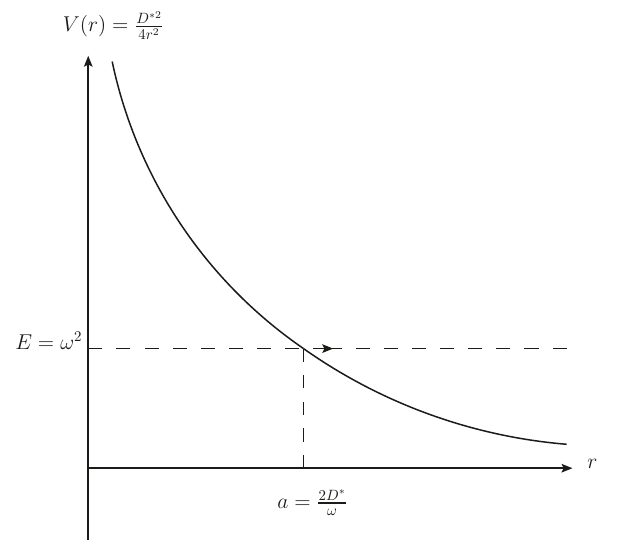
Figure 1 . Potential for allowed and disallowed